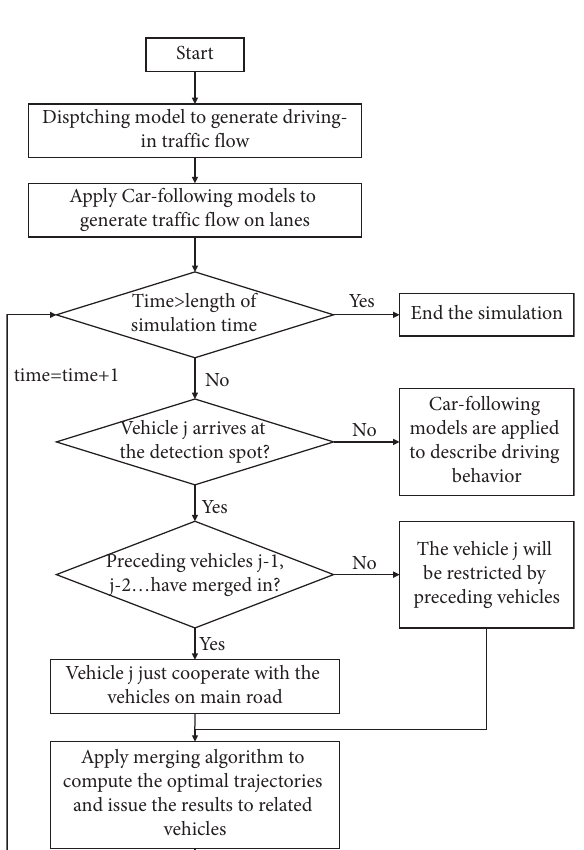
Figure 2: Te algorithm’s fowchart of consecutive trafc